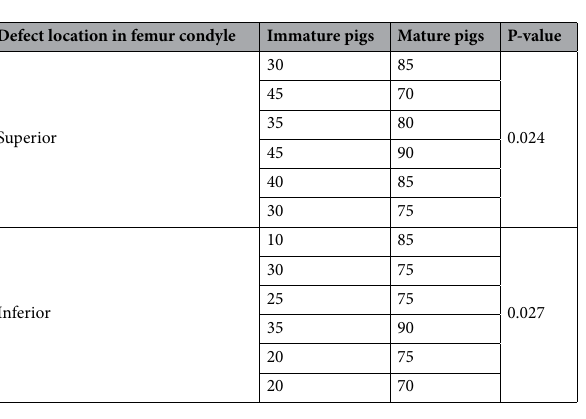
Table 1. MOCART score of superior and inferior defects of immature and mature pigs.